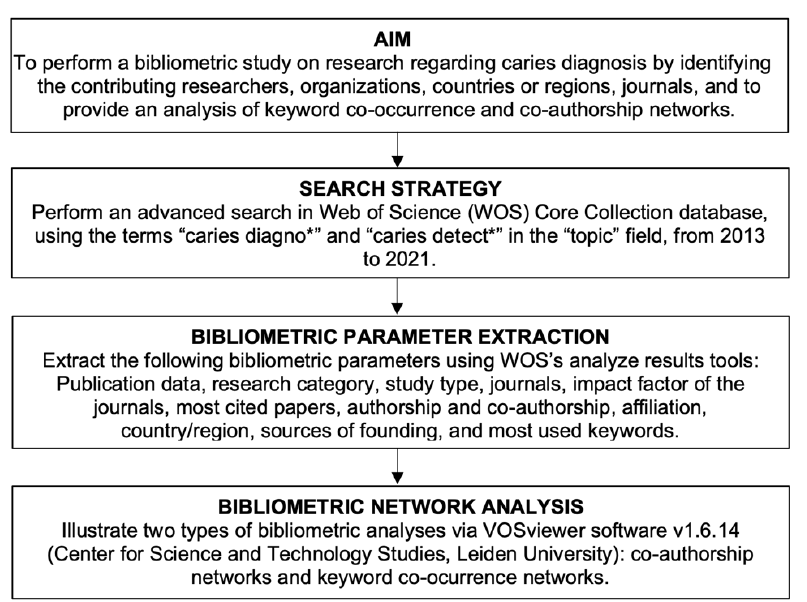
Figure 1. Study protocol.